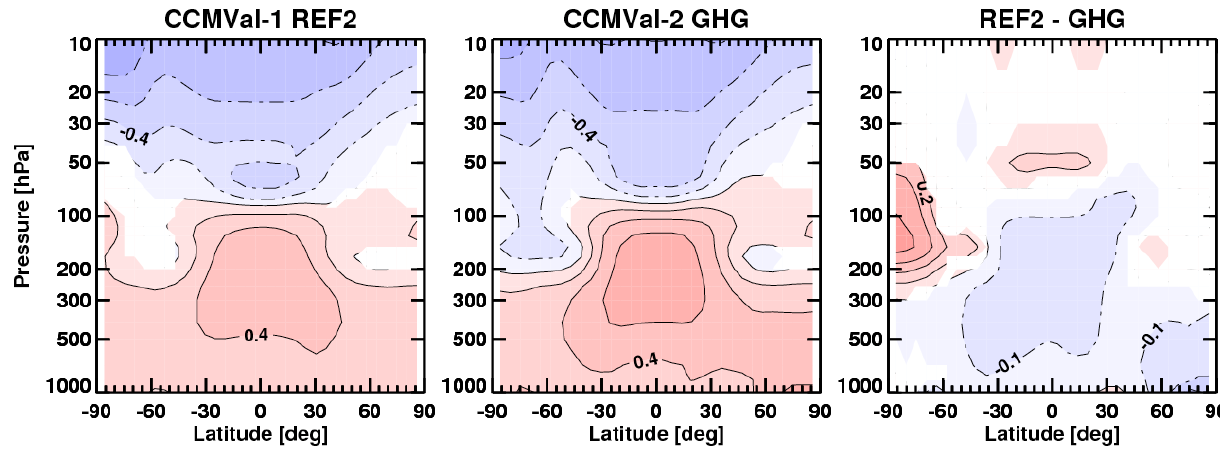
Fig. 4. Annual and zonal mean temperature trends for 2001–2050: CCMVal-1 REF2 (left), CCMVal-2 GHG (middle), and CCMVal-1 REF2 minus CCMVal-2 GHG (right). Contour intervals are 0.2 and 0.1Kdecade − 1 in the two left panels and the right panel, respectively, with red denoting positive values and blue negative. Only trends that are significant at the 95% level are shown.